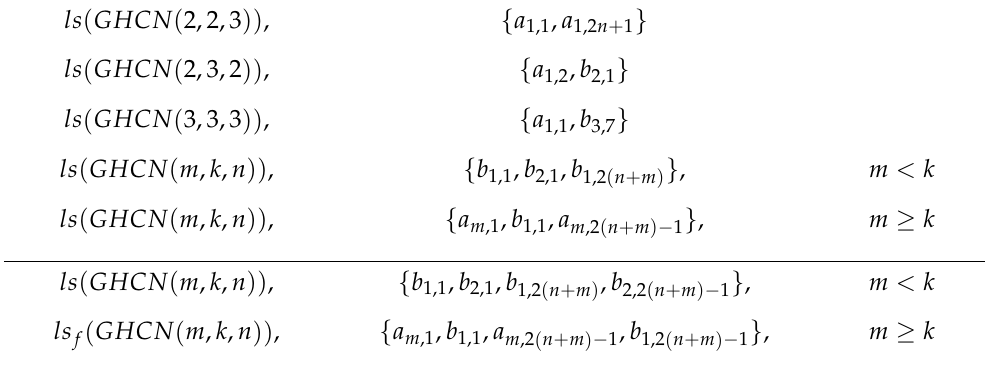
Table 7. Locating sets of GHCN ( m , k , n ) .